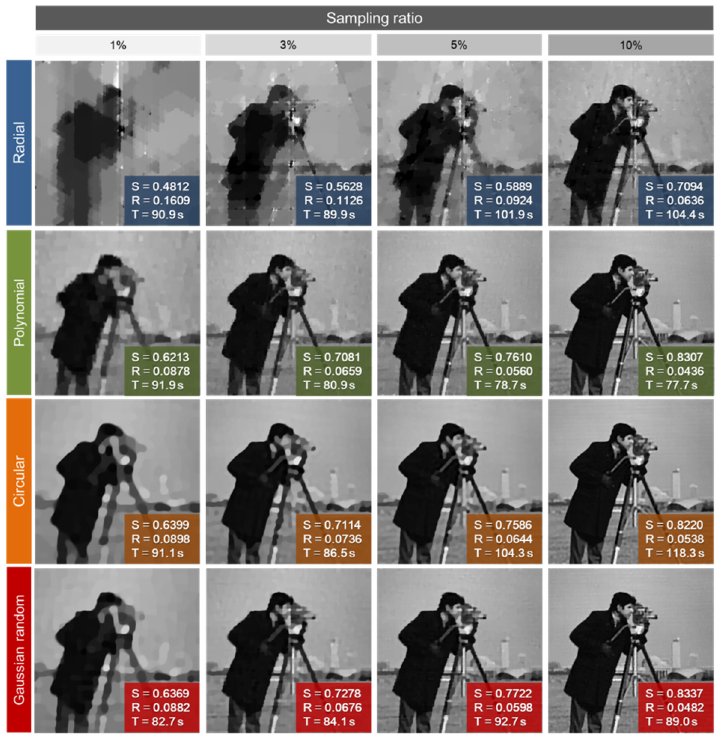
Figure 5. Comparison of the reconstruction results of “Cameraman” for different sampling strategies and sampling ratios. The SSIM, RMSE, and image reconstruction time (denoted by S, R, and T, respectively) are given in the inset of each reconstruction.